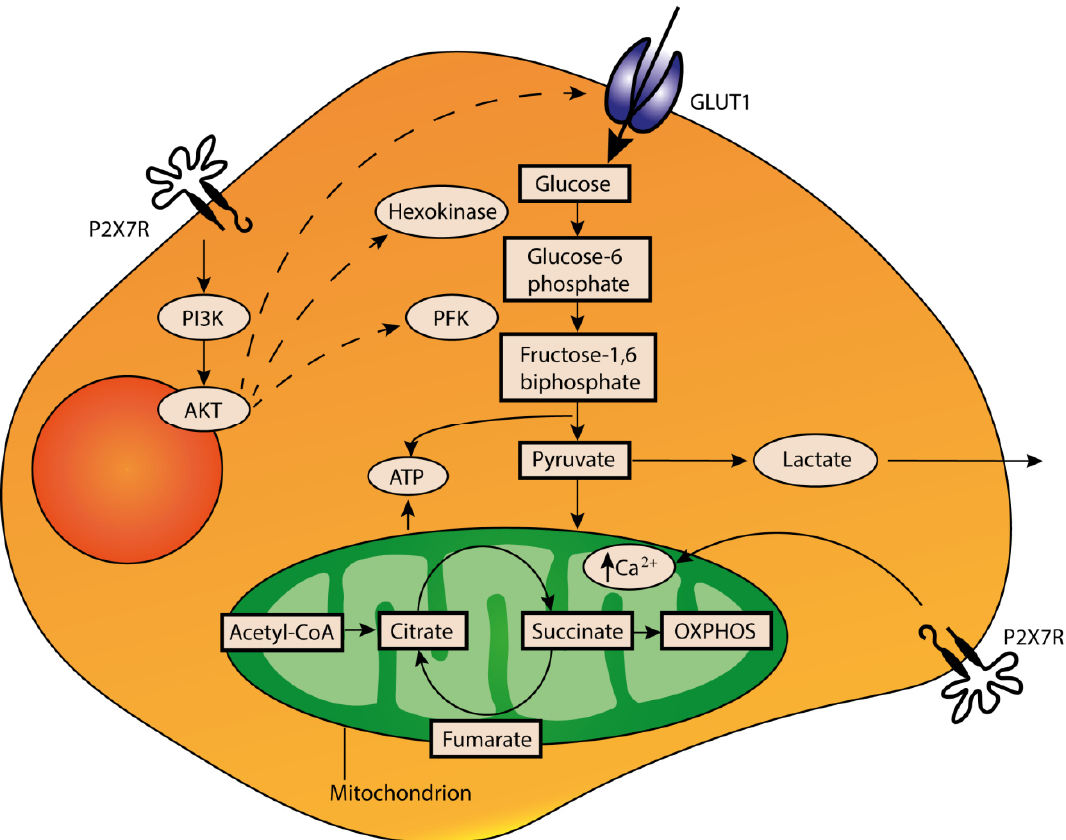
Figure 3. Stimulation of cancer cell metabolism. Extracellular ATP acting at P2X7R causes an increase in the mitochondrial Ca 2+ level, stimulates oxidative phosphorylation (OXPHOS) and promotes ATP generation. At the same time, P2X7R activation upregulates via PI3K-AKT expression of the plasma membrane glucose transporter GLUT1 and of several enzymes of the glycolytic cascade. This generates ATP and, at the same time, increases the production of lactate, which causes acidification of TME.